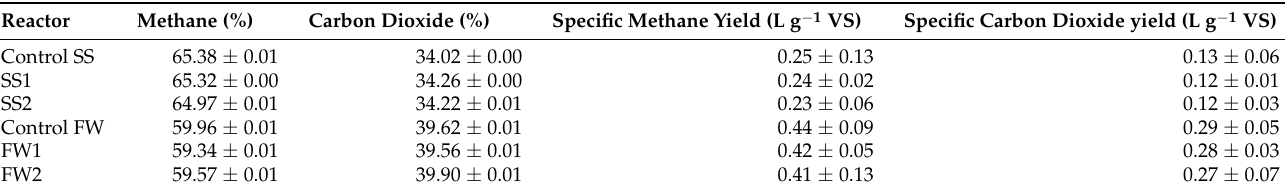
Table A3. Results of baseline AD experiments across all reactors.